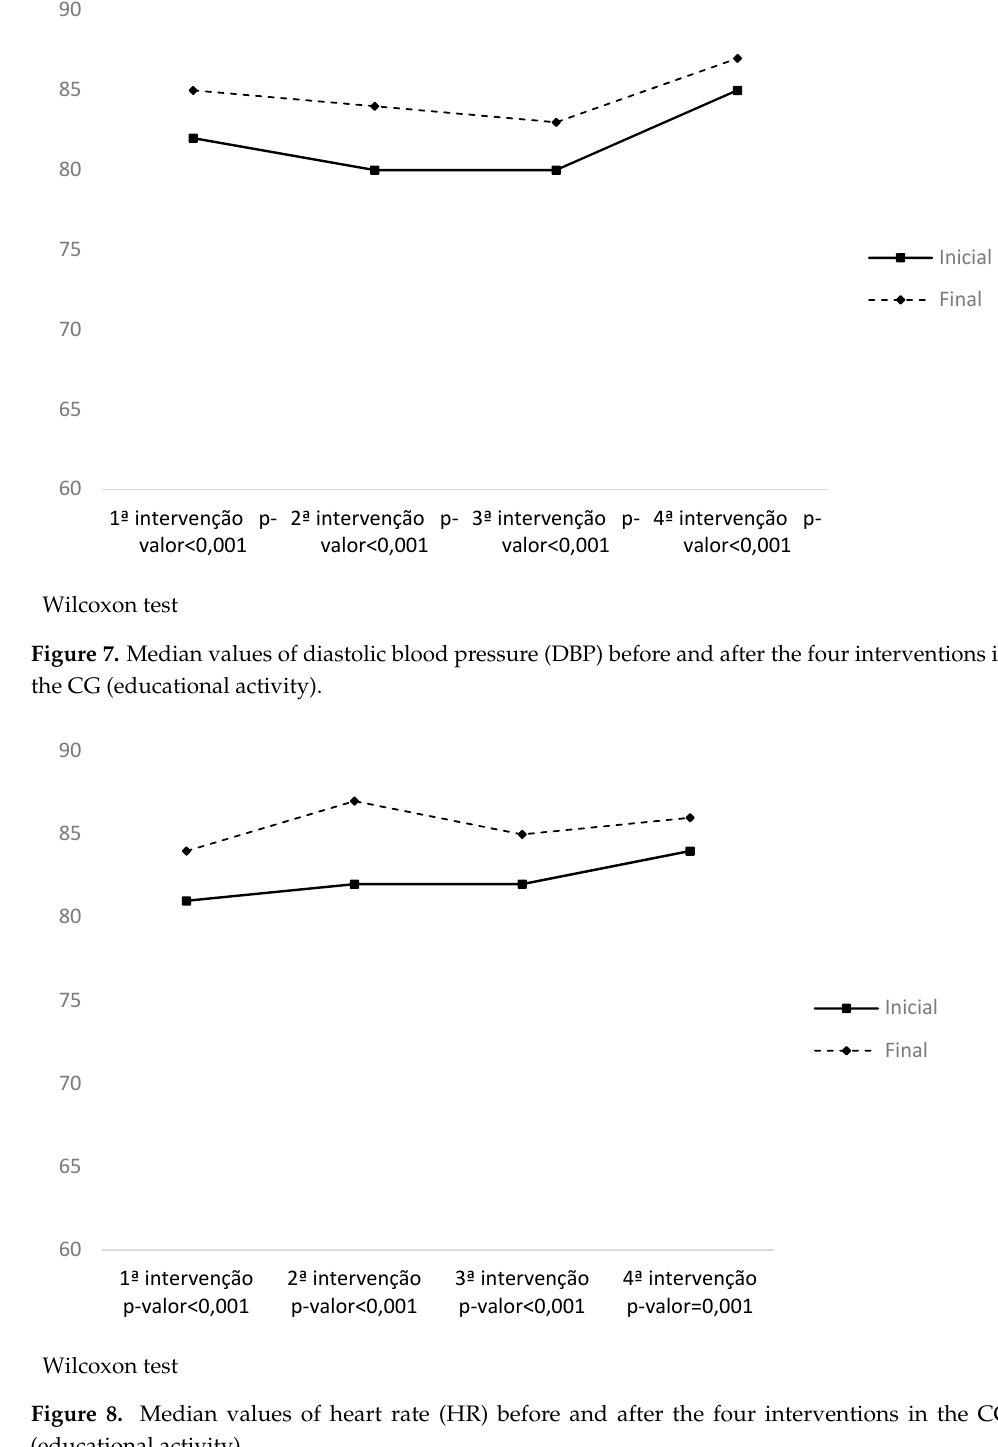
Figure 8. Median values of heart rate (HR) before and after the four interventions in the CG (educational activity).